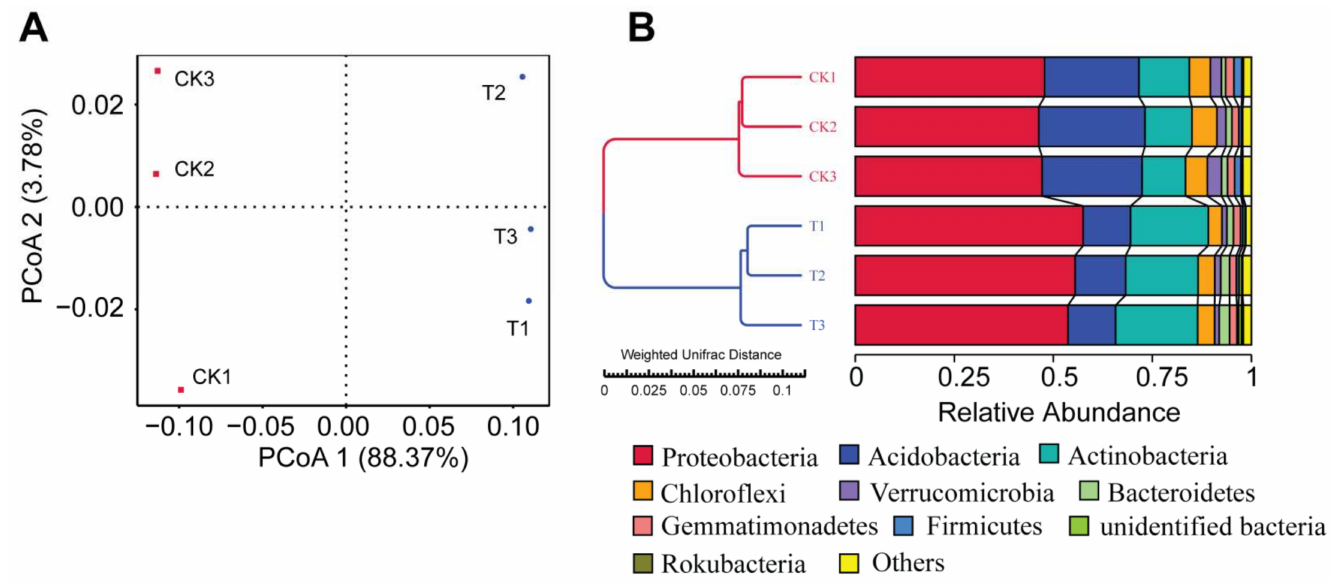
Figure 3. Bioorganic fertilizer alters bacterial community beta diversity. ( A ) PCoA analysis based on weighted UniFrac distance of rhizosphere bacterial communities at the phylum level in the bioorganic fertilizer and no-fertilizer treatments. ( B ) The UPGMA tree is showing clusters of bacterial communities at the phylum level based on weighted UniFrac distance.